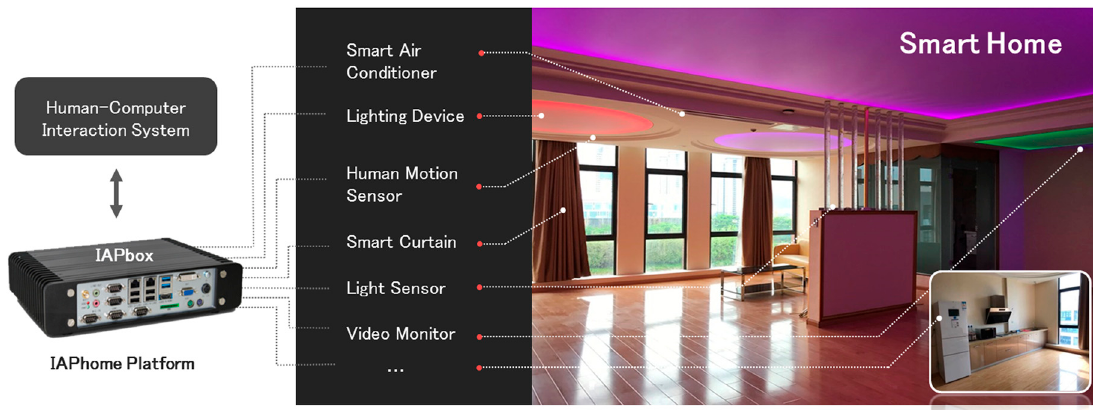
Figure 8. Smart home lab environment.